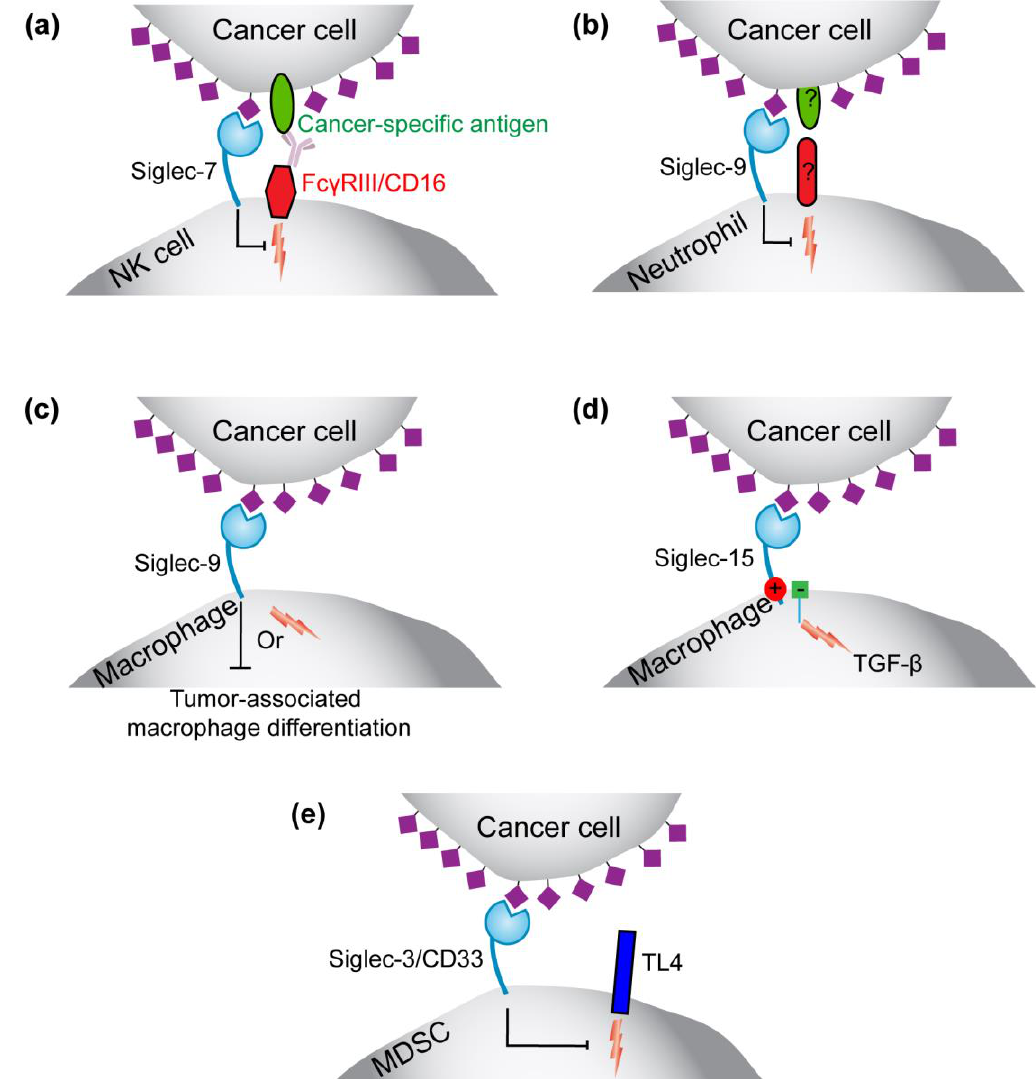
Figure 2. Roles for hypersialylation on cancer in modulating Siglecs on immune cells. ( a ) Siglec-7 (and potentially Siglec-9) on NK cells can be drawn into an immunological synapse formed with a cancer cell to inhibit an activatory receptor (e.g., CD16), thereby inhibiting NK cell-mediated killing; ( b ) Siglec-9 on neutrophils can be engaged by hypersialylation of cancer cells and prevent neutrophil-mediated killing of cancer cells through an unknown activatory receptor and ligand on the cancer cells; ( c ) Siglec-9 on macrophages can promote or inhibit skewing of macrophages to a tumor-associated or tumor-promoting phenotype through engagement of sialic acid-containing glycans on cancer cells; ( d ) Siglec-15 on macrophages pairs with the adapter protein Dap12 to activate cellular signaling in response to sialic acid ligands on cancer cells, thereby inducing TGF-β production; ( e ) CD33 (Siglec-3) on myeloid-derived suppressor cells (MDSCs) has been shown to modulate inflammatory responses through modulating TLR4.